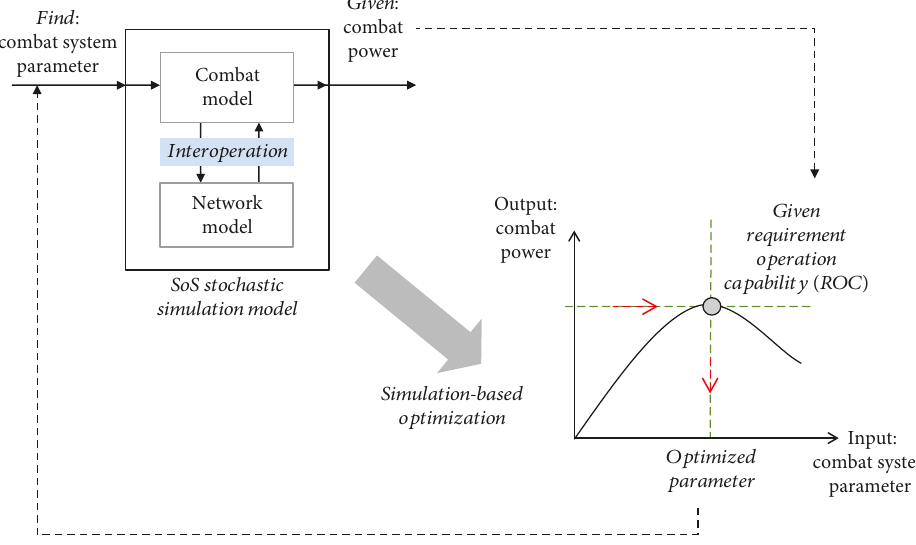
Figure 4: Optimization of the SoS-based NCW stochastic simulation